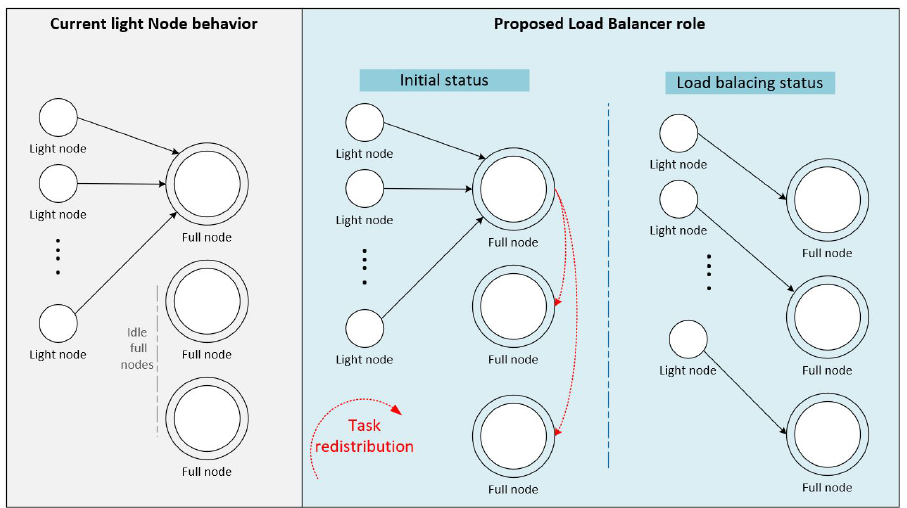
Figure 3. Load balancer role: each node should act as a load balancer to distribute the incoming random tasks fairly among full